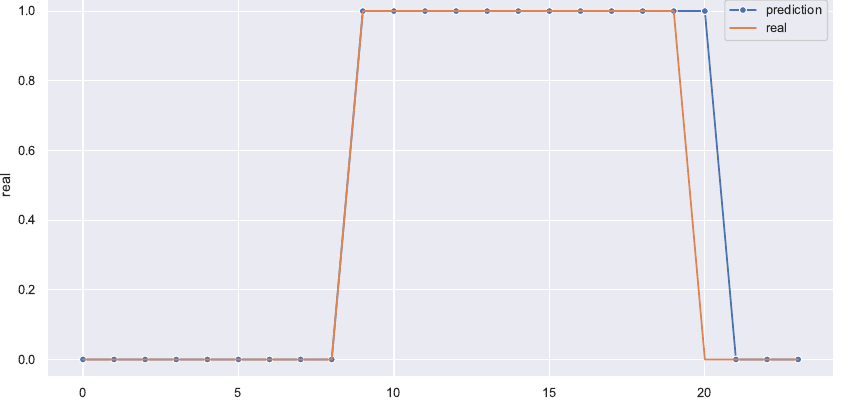
Figure 8. The framework prediction versus reality (24 h ahead) for the case of binary data (0 or 1).